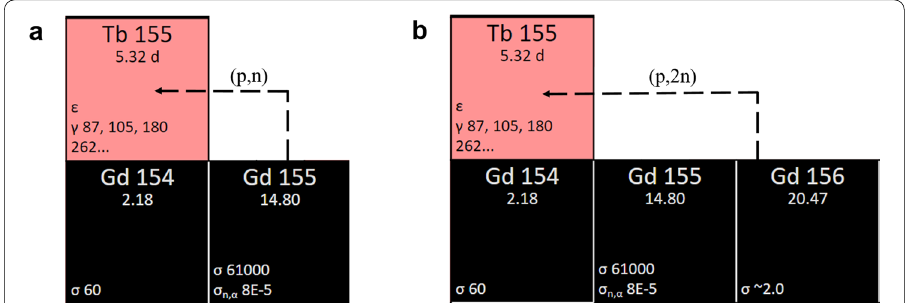
Fig. 1 Nuclear reactions for the production of terbium-155 via proton irradiation of enriched [ 155 Gd]Gd 2 O 3 and [ 156 Gd]Gd 2 O 3 targets. 155 Gd(p,n) 155 Tb ( a ) and 156 Gd(p,2n) 155 Tb ( b